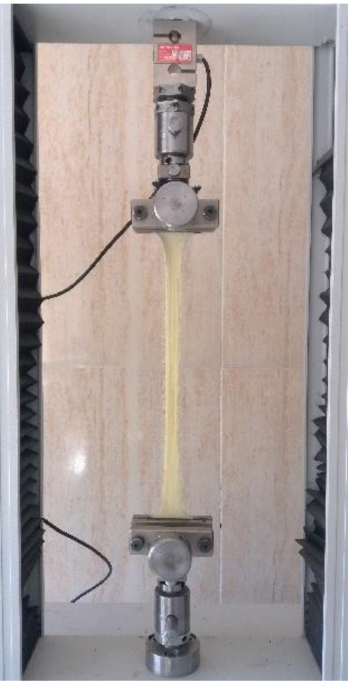
Figure 3. Tensile test of the